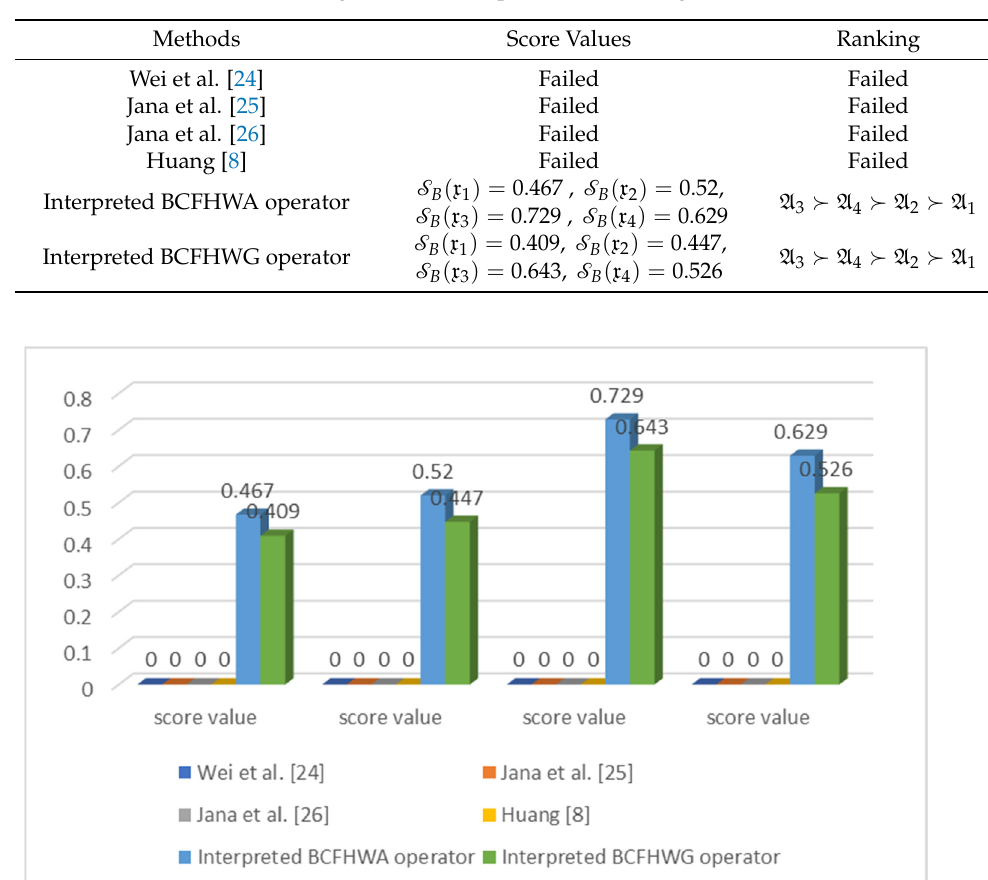
Table 2. Score values and ranking results of interpreted and existing work.